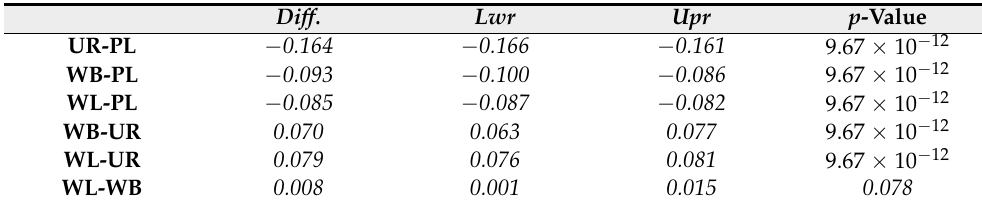
Table 8. Tukey HDS on NDVI standard deviation of all sampling pixels in each year. The table shows the difference ( Diff. ) between the mean values of the classes, lwr and upr show the lower and upper limits of the confidence intervals, respectively, and p -value shows the adjusted p -value for the tests. Values in bold show p -value < 0.05.